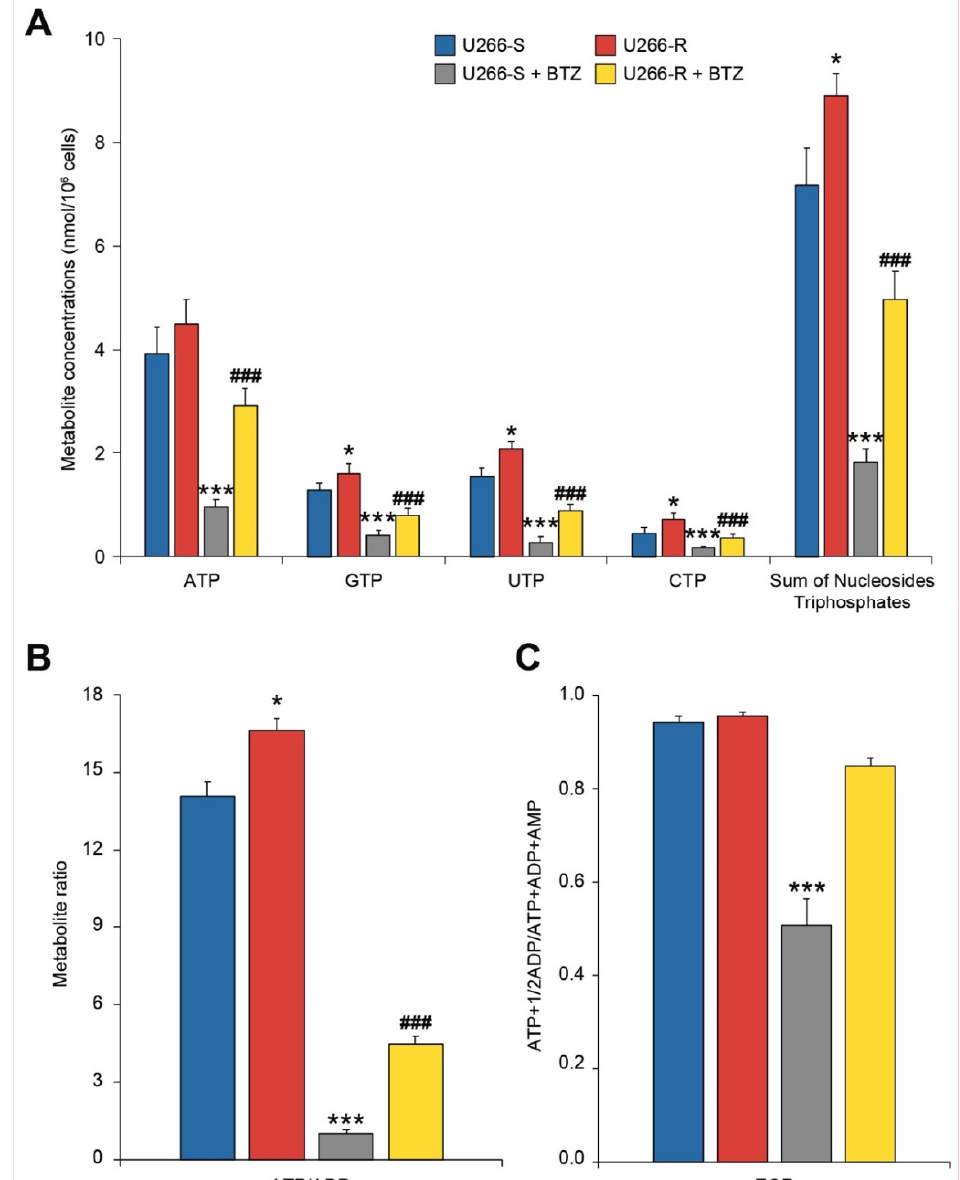
Figure 5. Cell energy states in U266-S and U266-R after exposure to BTZ. A – C ) Metabolite concentrations expressed as nmol per 10 6 cells ( A ), ATP / ADP ratio ( B ) and Energy Charge Potential (ECP) ( C ), in U266-S and U266-S + BTZ and in U266-R and U266-R + BTZ. Data are shown as mean ± SEM of n = 4 biological replicates; * p -value < 0.05 and *** p -value < 0.001 versus U266-S; ### p -value < 0.001 versus U266-S + BTZ.